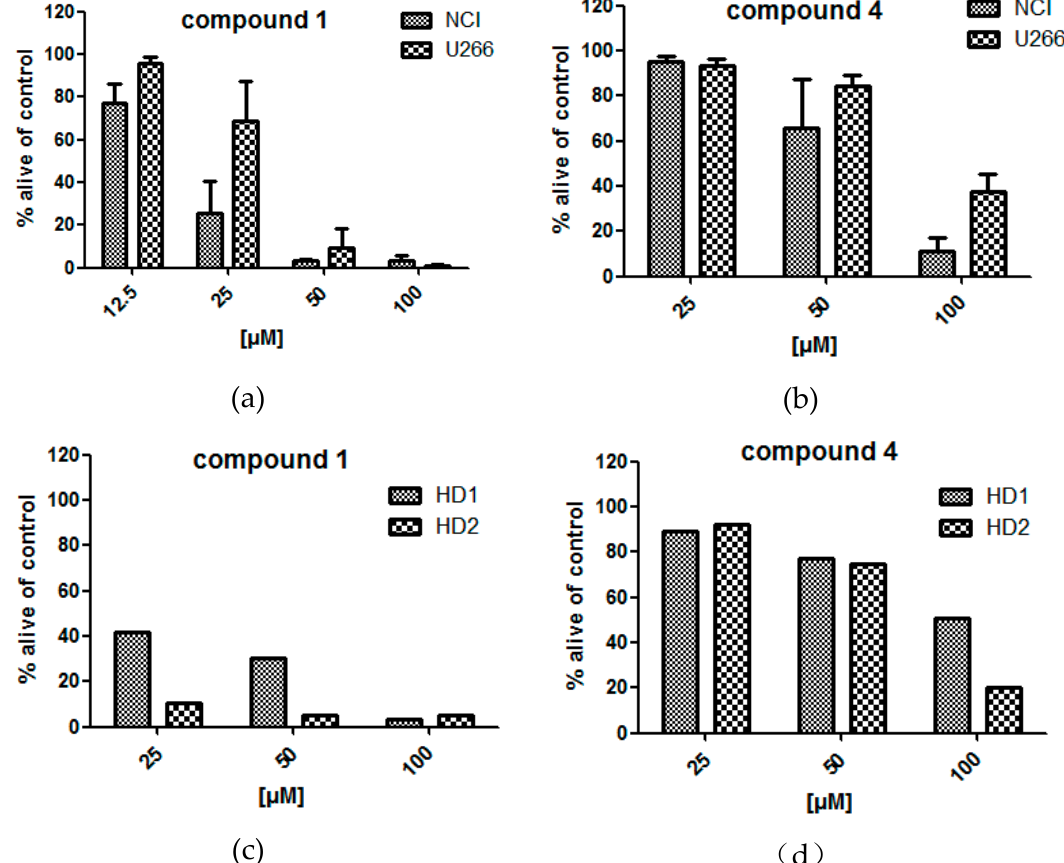
Figure 5. Viability of MM cell lines (U266, NCI-H929) ( a , b ) and healthy donor (HD) cells ( c , d ) 24 h after treatment with compounds 1 and 4 , respectively.